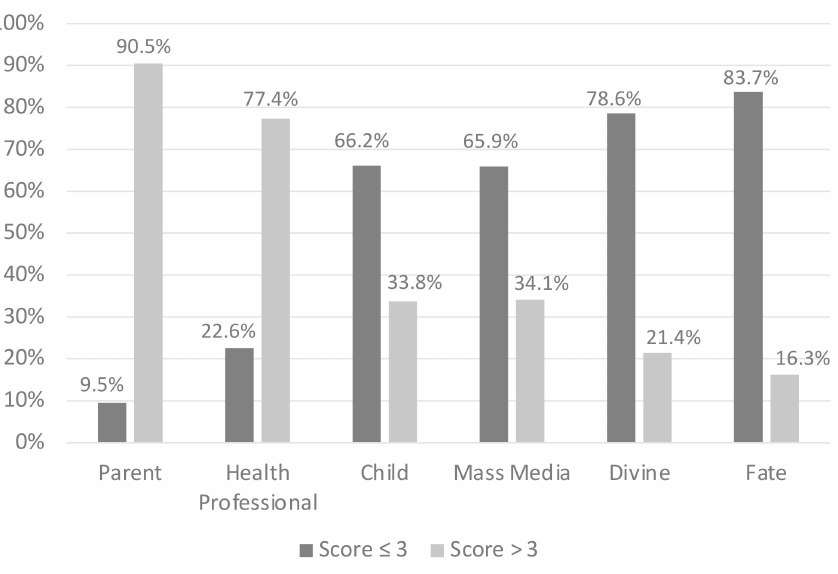
Figure 1. Parents’ disagreement (score ≤ 3) or agreement (score > 3) to the six subscales of PHLOC. The highest percentages of responses with a score > 3, showing a high agreement of the parents enrolled, are found in the categories of “Parent” (90.5% of responses) and “Health professionals“ (77.4% of responses); the lowest percentages are instead found in the categories of “Divine” and “Destiny”, respectively, with 21.4% and 16.3% of responses with a score > 3. Regarding the answers with a score ≤ 3 on the Likert scale, the highest percentages were observed in the categories “Fate” (83.7%) and “Divine” (78.6%), while the lowest percentages were observed in the subgroups “Parent” (9.5%) and “Health workers”